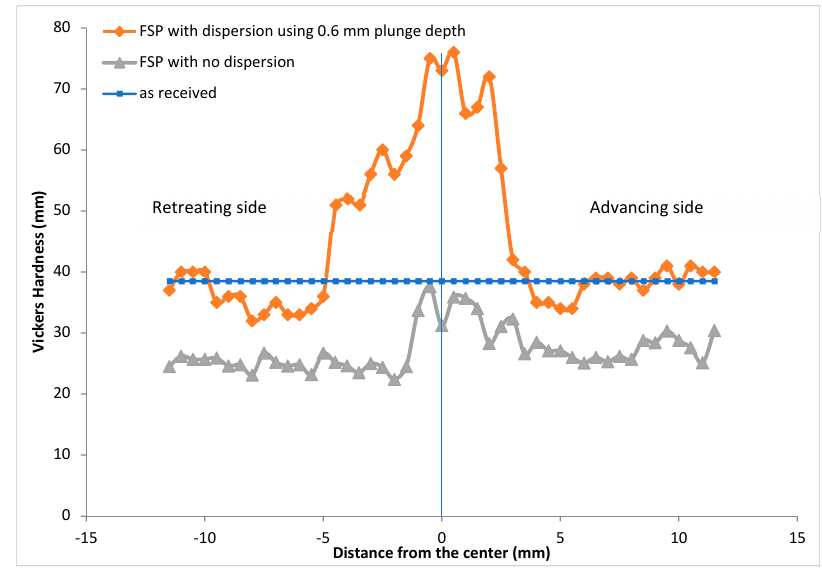
Figure 10. Vickers microhardness profile of a horizontal line at the upper layer of the sample.